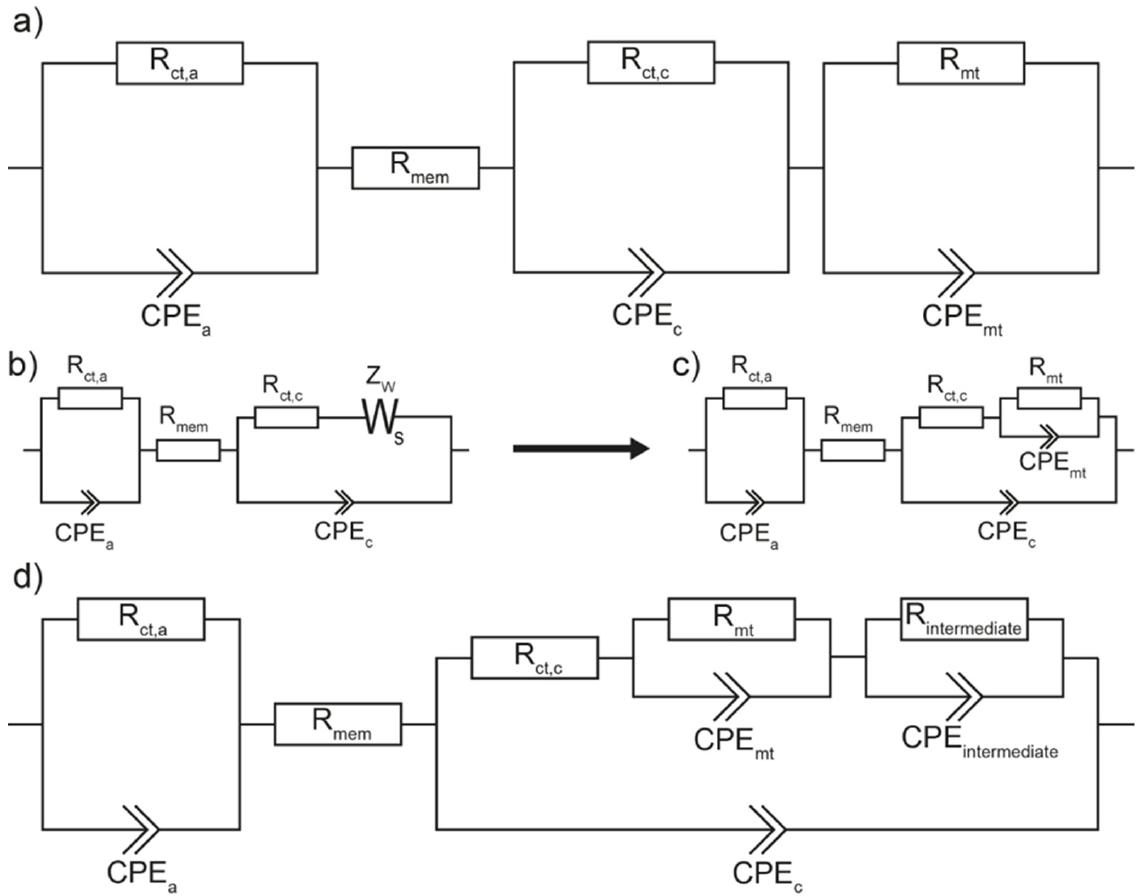
Figure 1. Summary of the equivalent circuit models used in the literature: ( a ) equivalent circuit proposed by Wagner, Schulze at al. (Model 1); ( b ) equivalent circuit using a R-CPE element for the charge transfer at anode side and a Randles circuit for the charge transfer at the cathode and the diffusion of oxygen (Z W ); ( c ) equivalent circuit to that in Figure 1b in which the finite Warburg element has been changed to a R-CPE element; ( d ) our proposed model (Model